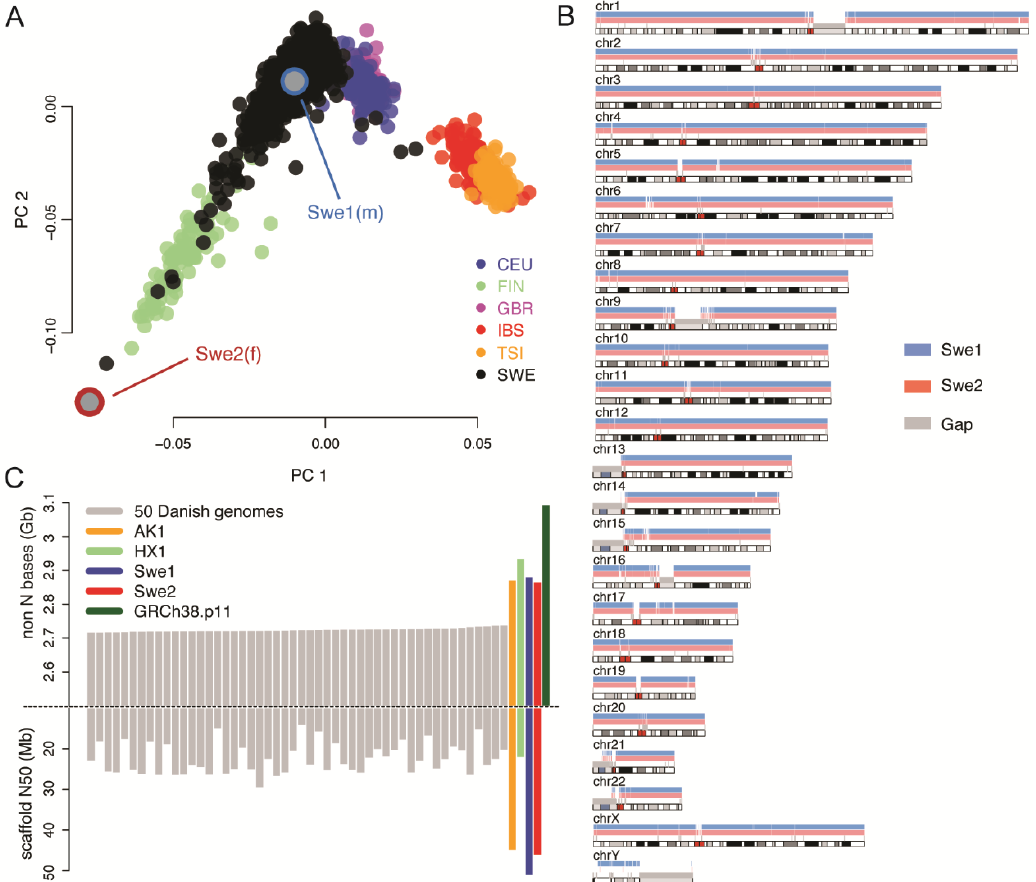
Figure 1. Selection of individuals and de novo assembly results. ( A ) Results of principal component analysis (PCA) of whole genome sequencing (WGS) data from the SweGen project [1], compared to the European 1000 Genomes data [27] (CEU: Utah Residents with Northern and Western Ancestry, FIN: Finnish in Finland, GBR: British in England and Scotland, IBS: Iberian Population in Spain, TSI: Toscani in Italia). The black dots indicate 942 samples from the Swedish Twin Registry (STR), which were sequenced within the SweGen project and represent a cross-section of the Swedish population. Swe1 and Swe2 are the individuals selected for de novo sequencing. ( B ) Alignment of contigs for Swe1 (blue) and Swe2 (red) to the human GRCh38 reference. A total of 6812 contigs could be aligned for Swe1 and 6924 for Swe2. Only the male Swe1 sample has extensive coverage of the Y chromosome. ( C ) The bars show the total number of non-N bases (top) and scaffold N50 values (bottom) for Swe1, Swe2, and a selection of other human de novo assemblies. The grey bars represent the top 50 genomes with the highest number of non-N bases from an Illumina mate-pair assembly of 150 individuals [10]. The Korean (AK1) and Chinese (HX1) genomes were assembled by a combination of single-molecule real-time (SMRT) sequencing and optical mapping. Scaffold N50 is not shown for GRCh38 (in green) since it is much higher than for the personal genomes and difficult to fit into the same plot.